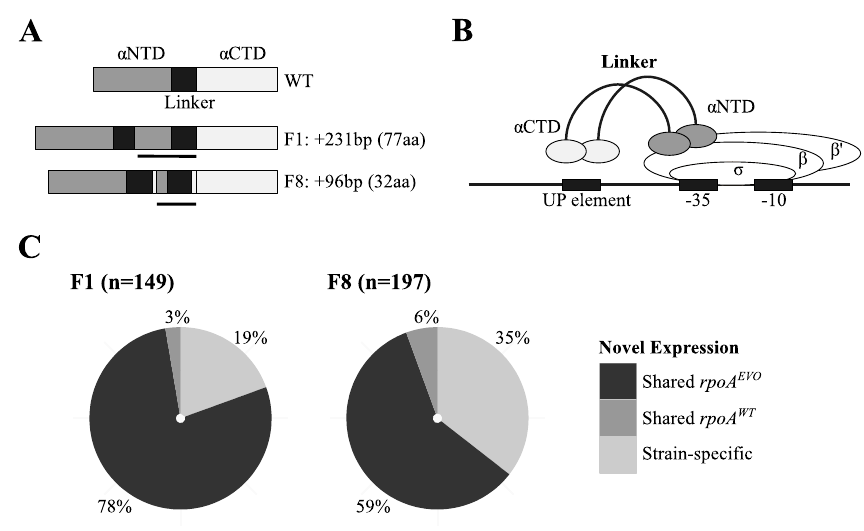
Figure 2. Mutations that extend the RNAP linker are linked to unique gene expression in F1 and F8. ( A ) Wild-type RpoA consists of  NTD and  CTD domains connected by an unstructured linker. F1 and F8 possess internal sequence duplications (black bar) that are hypothesized to extend both the linker and neighboring domains. ( B ) Bacterial RNAP is composed of five core subunits. Important to this work are the effects of linker extension mutations on the  NTD and the  CTD, which facilitate binding to DNA and co-regulatory proteins near UP binding sites. Modified from [58]. ( C ) F1 and F8 have up to 16-fold more genes with “novel” expression [10], most of which are uniquely shared between only these two strains relative to other F